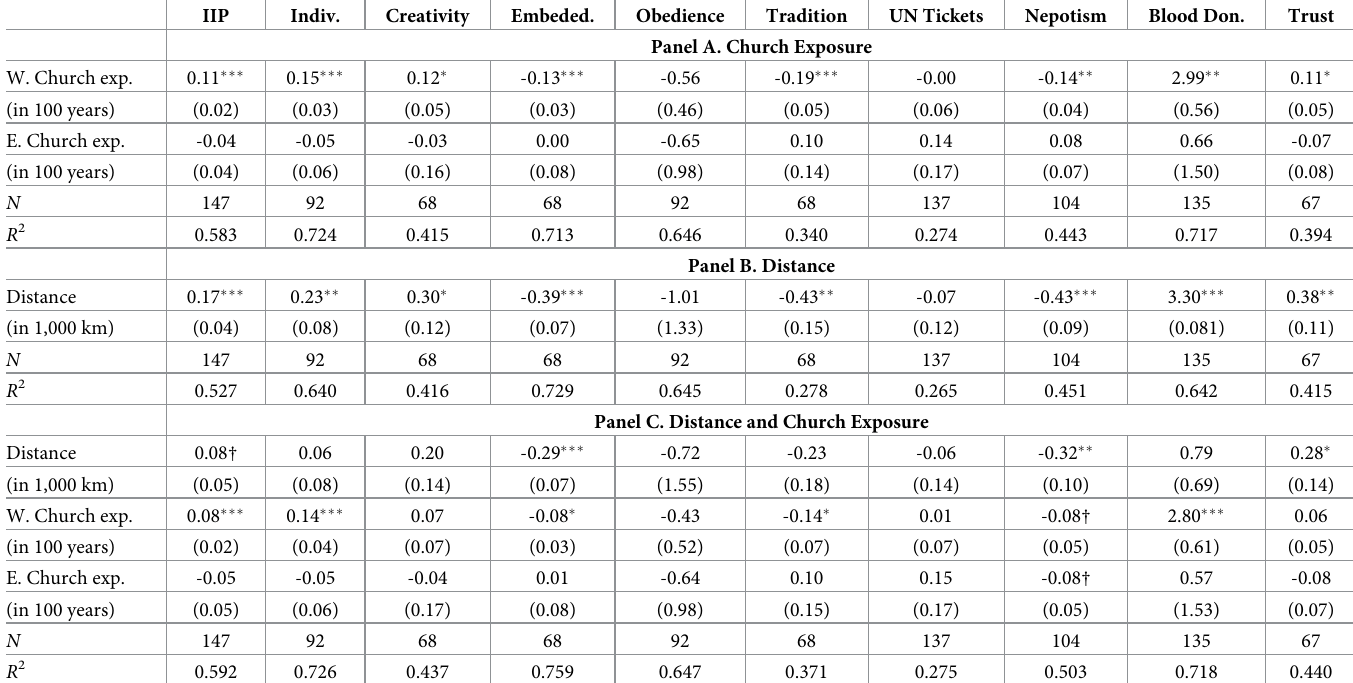
Table 3. Country-level regressions of psychological outcomes gon distance to innovations and Church exposure.